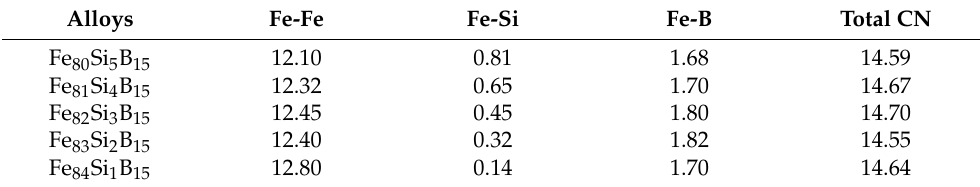
Table 2. Fe-centered total and partial CNs in the Fe 80+x Si 5 − x B 15 ( x = 0–4) alloys. Alloys Fe-Fe Fe-Si Fe-B